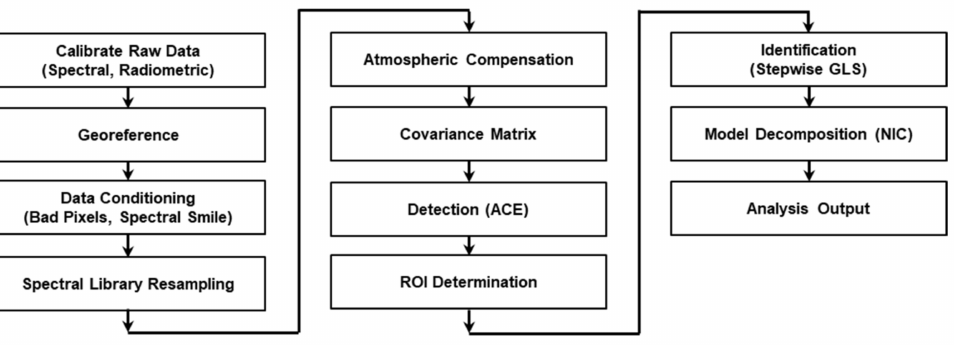
Figure 1. Top-level overview of the data processing